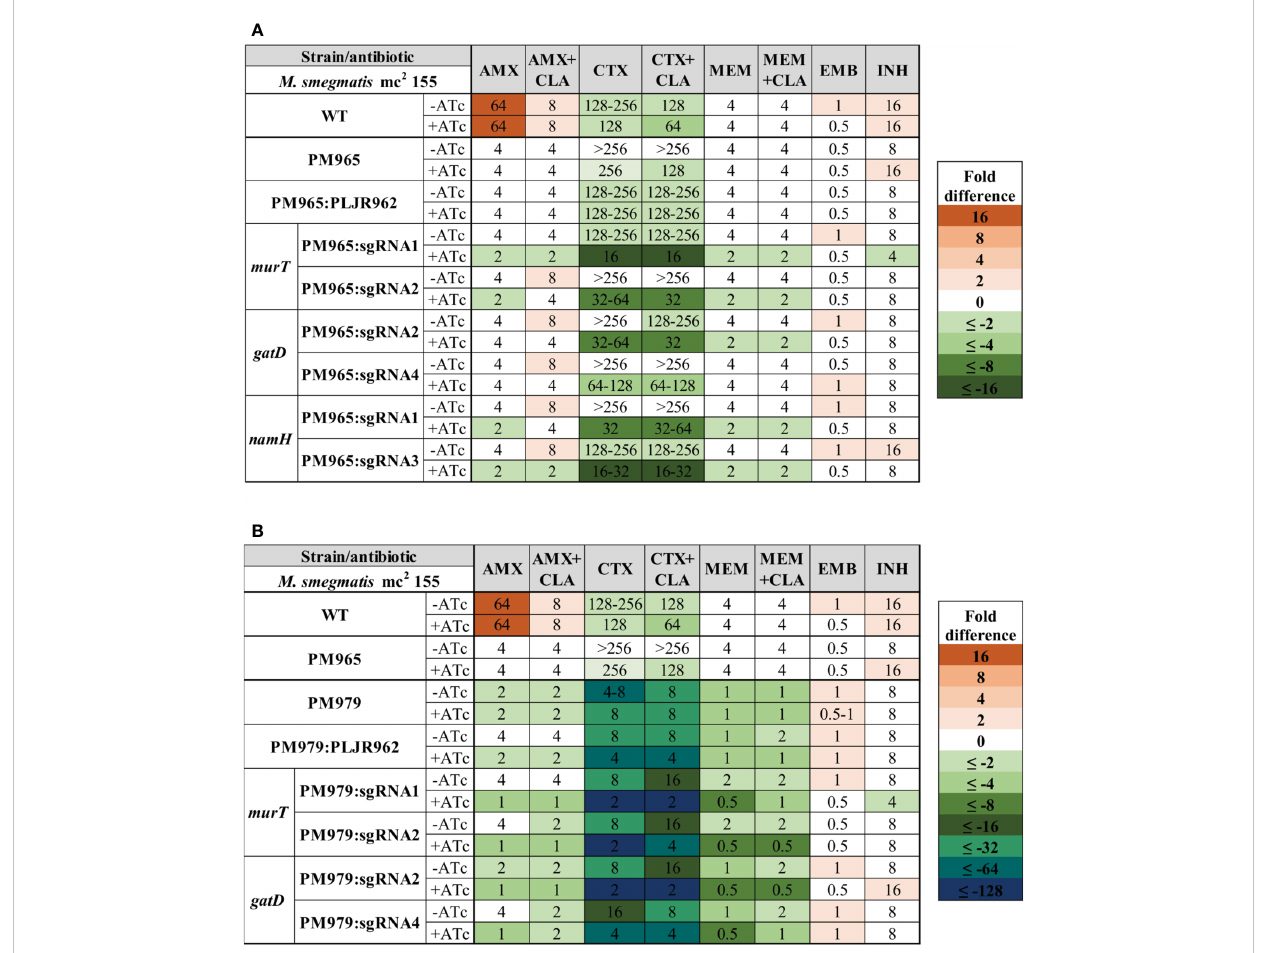
FIGURE 7 Heatmap of the fold differences in minimum inhibitory concentrations (MICs) of the double and triple knockdown mutants, with and without ATc. (A) Mutants constructed in M. smegmatis PM965 strain (double mutants); (B) Mutants constructed in the M. smegmatis PM979 strain (triple mutants). Columns represent the antibiotics and rows represent the strains. The median MIC (in µg/mL) of each antibiotic for each strain is shown in the respective intersection and colours depict an increase (red shades) or decrease (green/blue shades) in the value when compared to the MICs of control strain M. smegmatis PM965 ( D blaS1 ). AMX, amoxicillin; CLA, clavulanate; CTX, cefotaxime; EMB, ethambutol; INH, isoniazid; MEM,